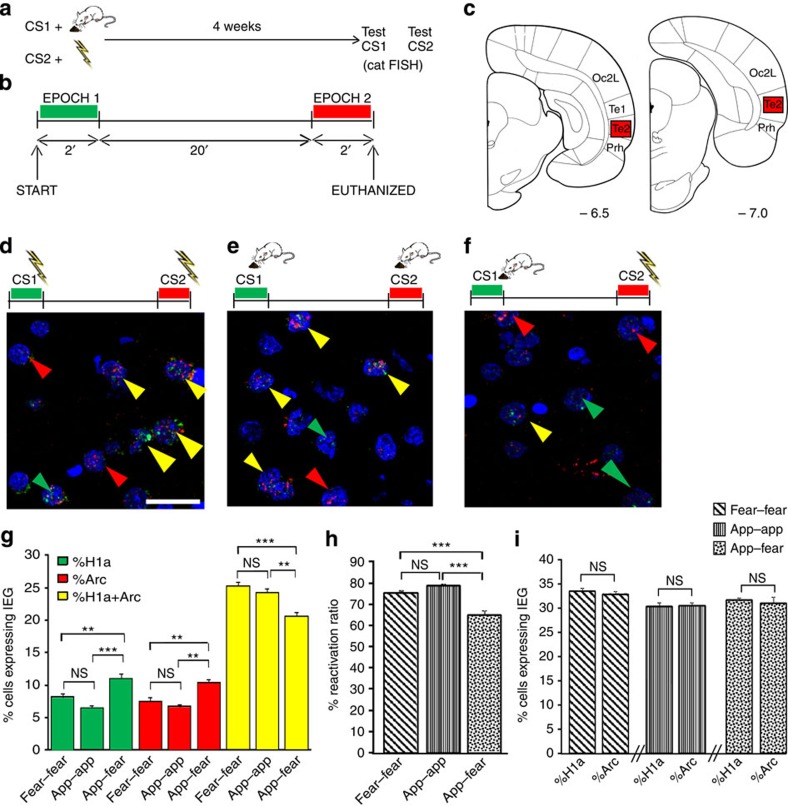
Te2 activity following the recall of aversive or appetitive remote memories.(a) Experimental design for appetitive–fear conditioning. Rats were trained to associate two different auditory stimuli (CSs) to opposite emotional experiences. One month after training, rats were tested for memory retention to CS1 and, after 20 min, to CS2. Immediately after testing, fluorescent in situ hybridization to detect Arc/Arg 3.1 (Arc) and Homer 1a (H1a) expression (catFISH method) was performed. CS1 and CS2, conditioned stimuli 1 and 2. (b) Time course for remote memory testing 1 month after training. Conditioned responses to CS1 were measured in a 2-min test and then, after a 20-min pause, responses to CS2 were measured. (c) Two cortical sections across Te2 cortex were analysed. Plates adapted from Zilles53. Oc2L, secondary occipital visual cortex; Prh, perirhinal cortex; Te1 and Te2, primary and secondary auditory cortices. (d) Representative fluorescent photomicrographs showing neuronal nuclei that expressed primarily H1a mRNA (green arrowheads) or Arc mRNA (red), or that expressed both (yellow) in fear–fear (d), appetitive-appetitive (app-app), (e) and appetitive–fear (f) groups. Scale bar, 20 μm. (g) Percentage of cells expressing immediately early genes (IEG) (only H1a, only Arc, or both genes) in fear–fear conditioned rats (n=9), appetitive–appetitive conditioned rats (n=6), and appetitive–fear conditioned rats (n=8). The percentages of neurons expressing only H1a (F(2,20)=16.61, P<0.001) and only Arc (F(2,20)=12.51, P<0.001) were significantly higher in the appetitive–fear group than in either the fear–fear or appetitive-appetitive group, with a corresponding reduction in doubly labelled cells (F(2,20)=14.53, P<0.001). (h) The reactivation ratio, calculated as the percentage of cells expressing both Arc and H1a divided by the number of cells expressing H1a, was significantly less in the appetitive–fear group than in the fear–fear and appetitive-appetitive groups (F(2,20)=19.78, P<0.001). (i) In each group, the percentage of neurons activated during epoch 1 (H1a-positive cells) was similar to that of Arc (fear–fear, t16=0.69, NS; app–app, t10=0.26, NS; appetitive–fear, t14=−0.83, NS). **P<0.01, ***P<0.001; NS, not significant.